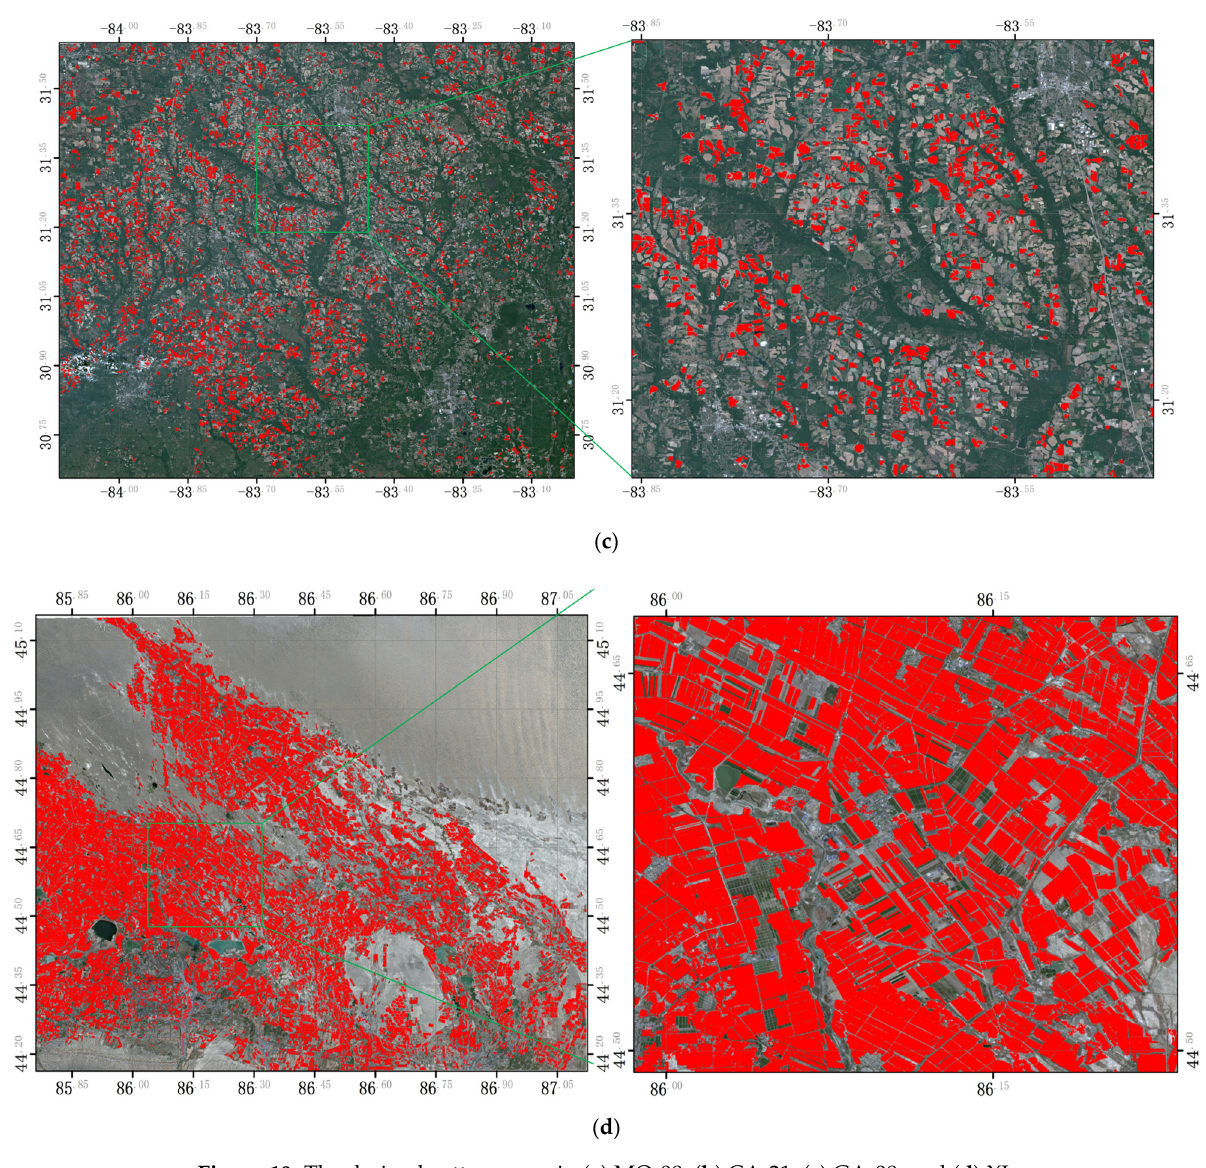
Figure 10. The derived cotton maps in ( a ) MO-08, ( b ) CA-21, ( c ) GA-08, and ( d ) XJ.